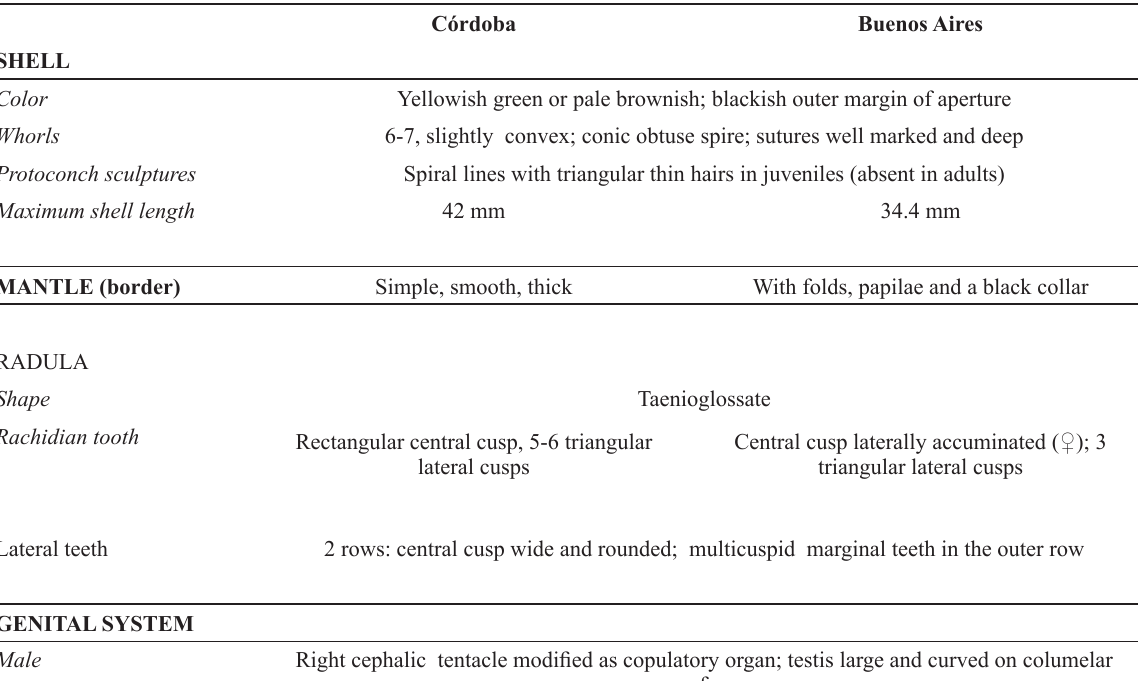
Anatomical similarities (merged columns) and differences (separated columns) between specimens found in Córdoba Province (after ovando and Cuezzo, 2012) and buenos aires Province (this